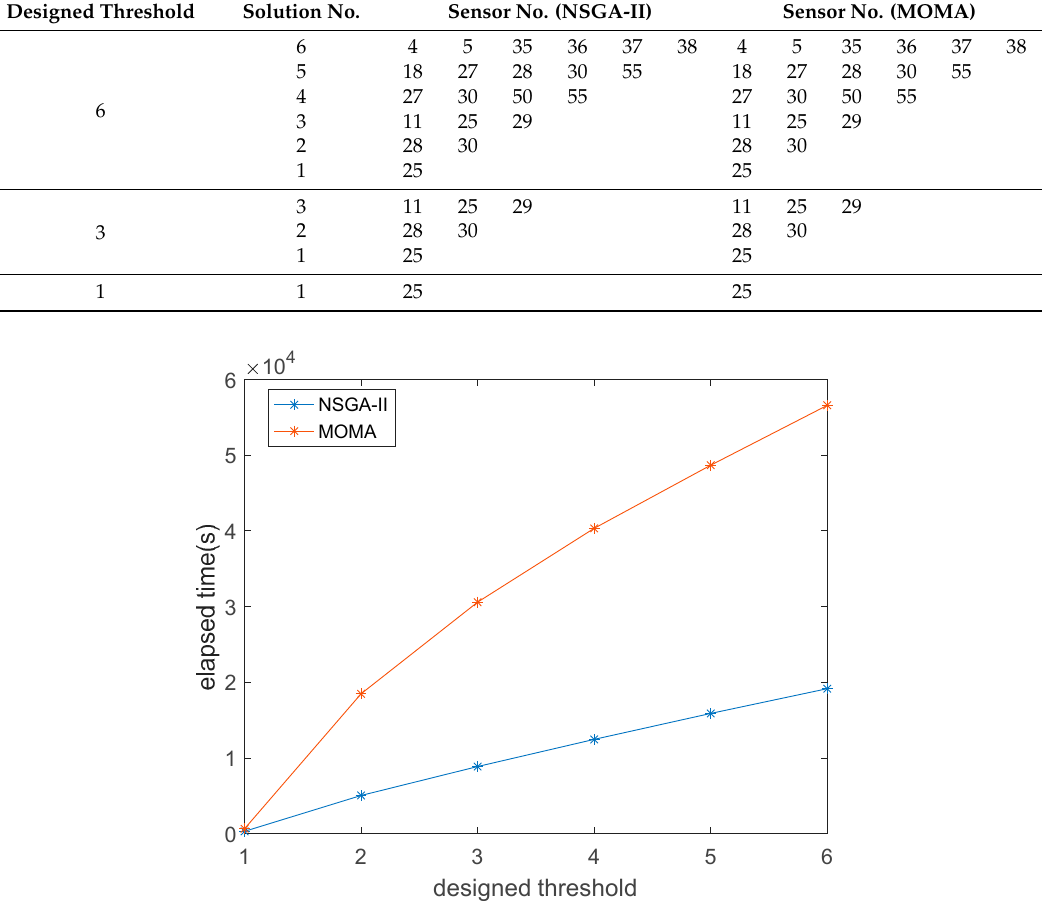
Table 3. Sensor sets of Pareto solutions with the different designed thresholds of sensor number.